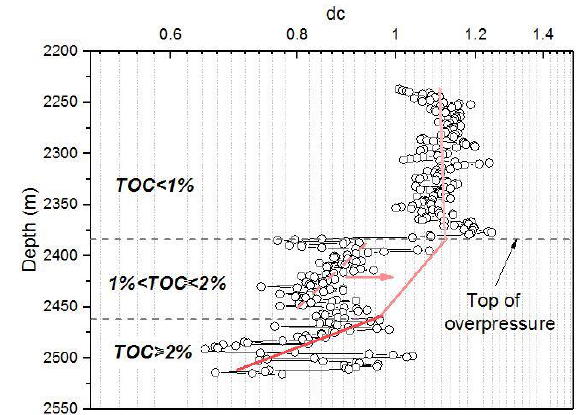
Figure 4. Depth profiles of the dc data of the O 3 w – S 1 l shales for well CN.